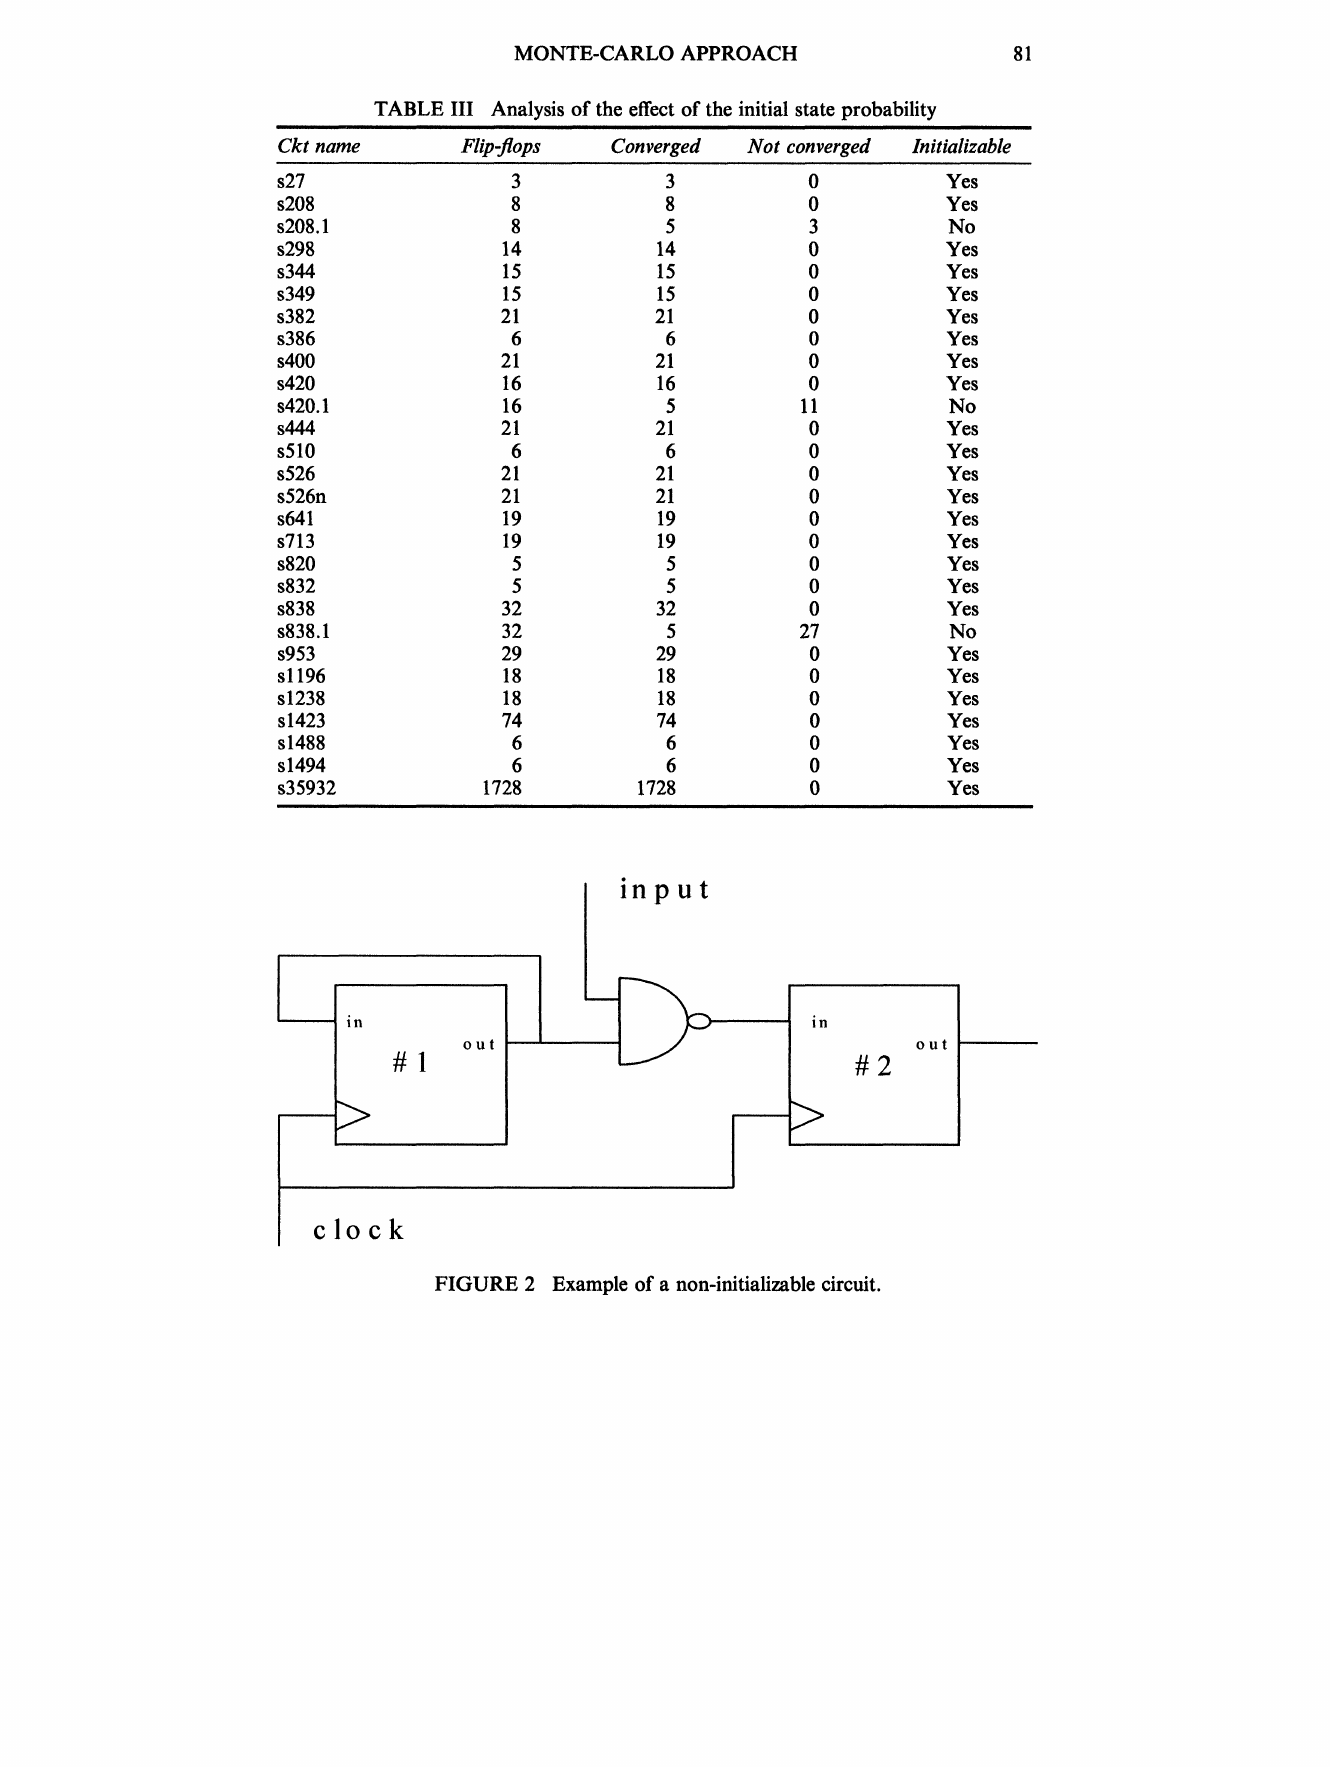
TABLE III Analysis of the effect of the initial state probability